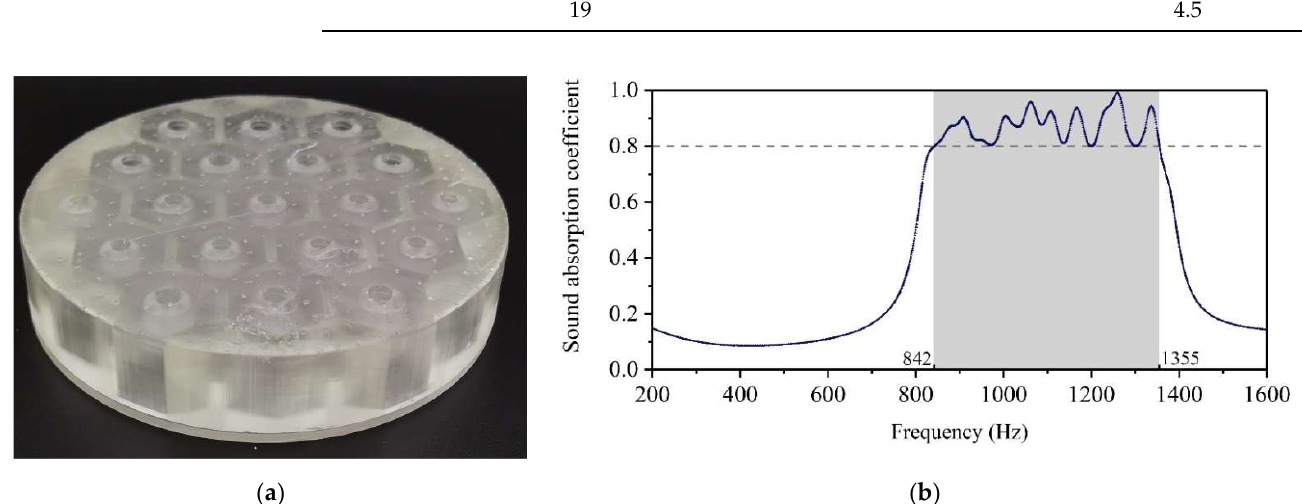
Figure 10. The optimization results of Condition-1. ( a ) Schematic diagram of the 3D printed sample with the diameter of 100 mm and the thickness of 20 mm. ( b ) The corresponding actual sound absorption coefficient.